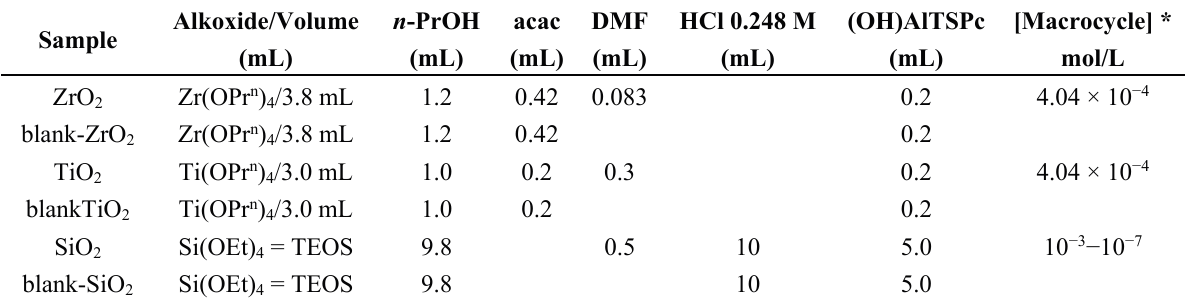
Table 2. Composition of the gellifying molar mixtures, as determined through the use of the (OH)AlTSPc species, employed as a probe for the synthesis of ZrO 2 , TiO 2 and SiO 2 translucent monolithic